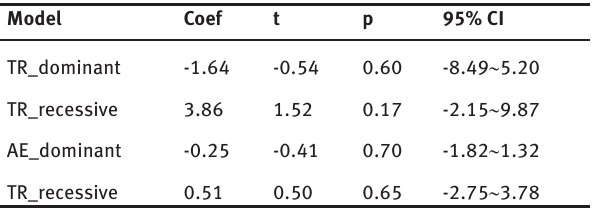
Table 2: The publication bias evaluation by Egger’s line regression